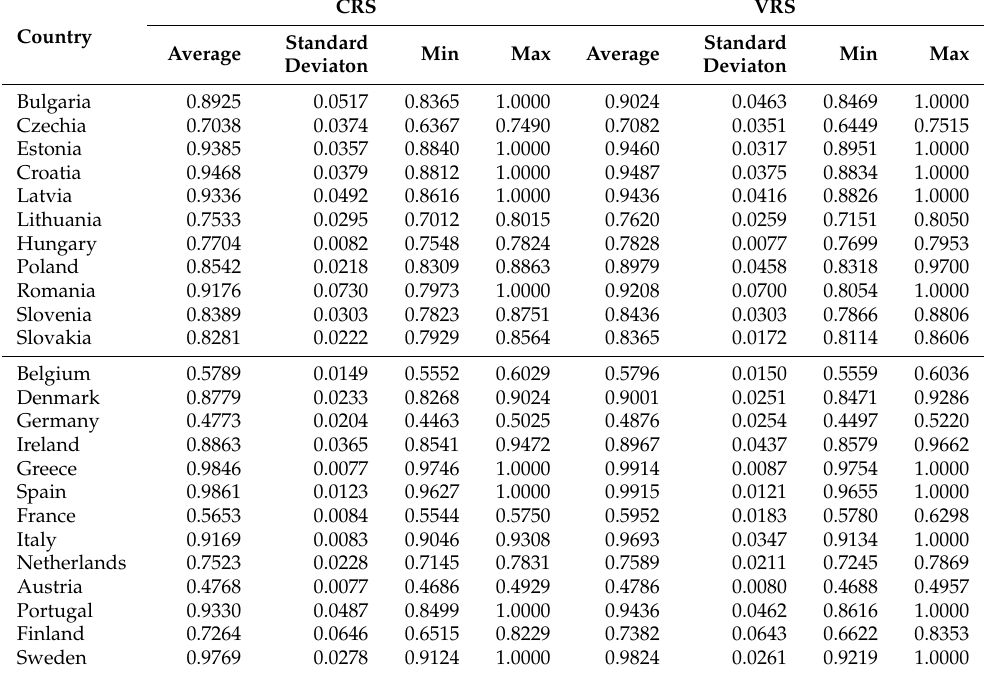
Table 3 summarizes the country-specific DEA results of the CRS and VRS models. Above the line are the countries that joined the EU after 2004 inclusive. Table 3. Summary results of DEA Window efficiency measurement.